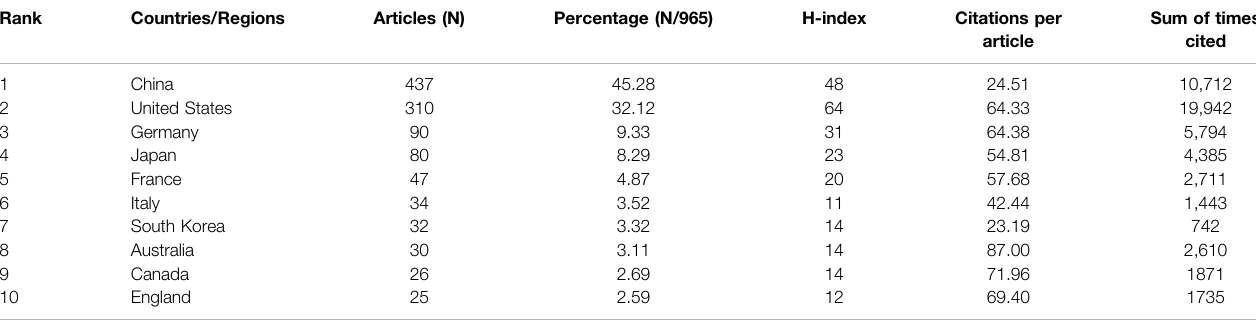
TABLE 1 | Top 10 productive country/regions related to ferroptosis in cancer research. Rank Countries/Regions